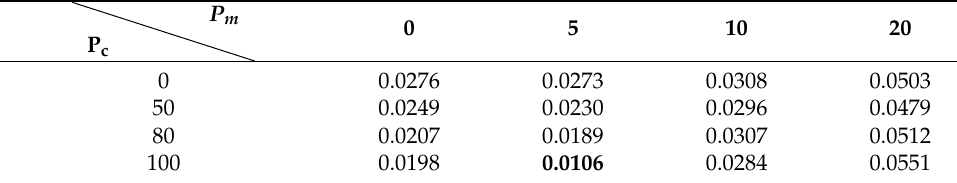
Table 6. Parameter optimization of crossover probability and mutation probability.